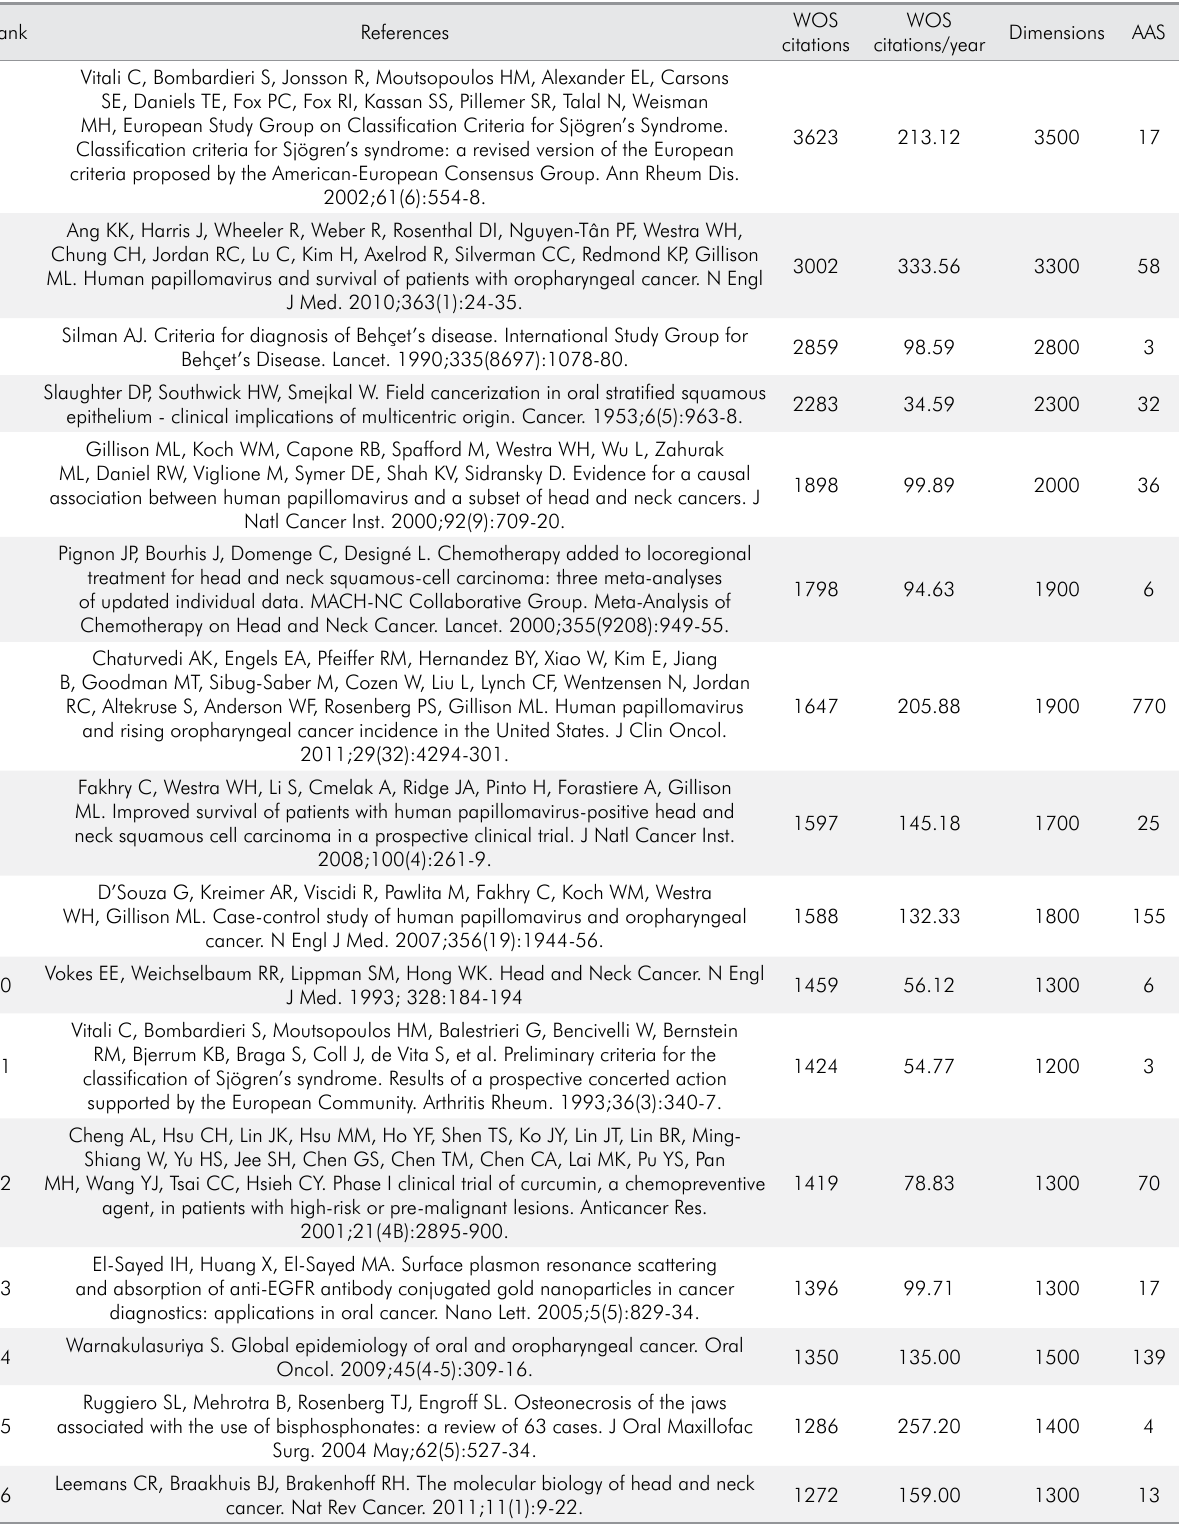
Table 1. The 100 most-cited papers in pathology and oral medicine, ordered by number of the